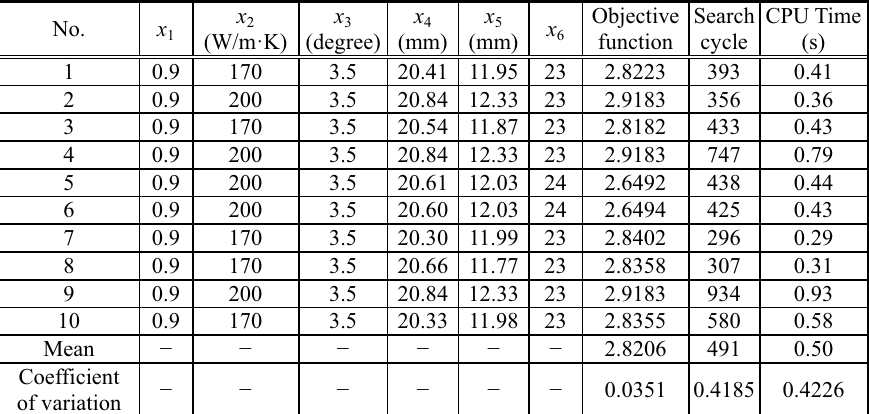
Table 10. Optimization results obtained by